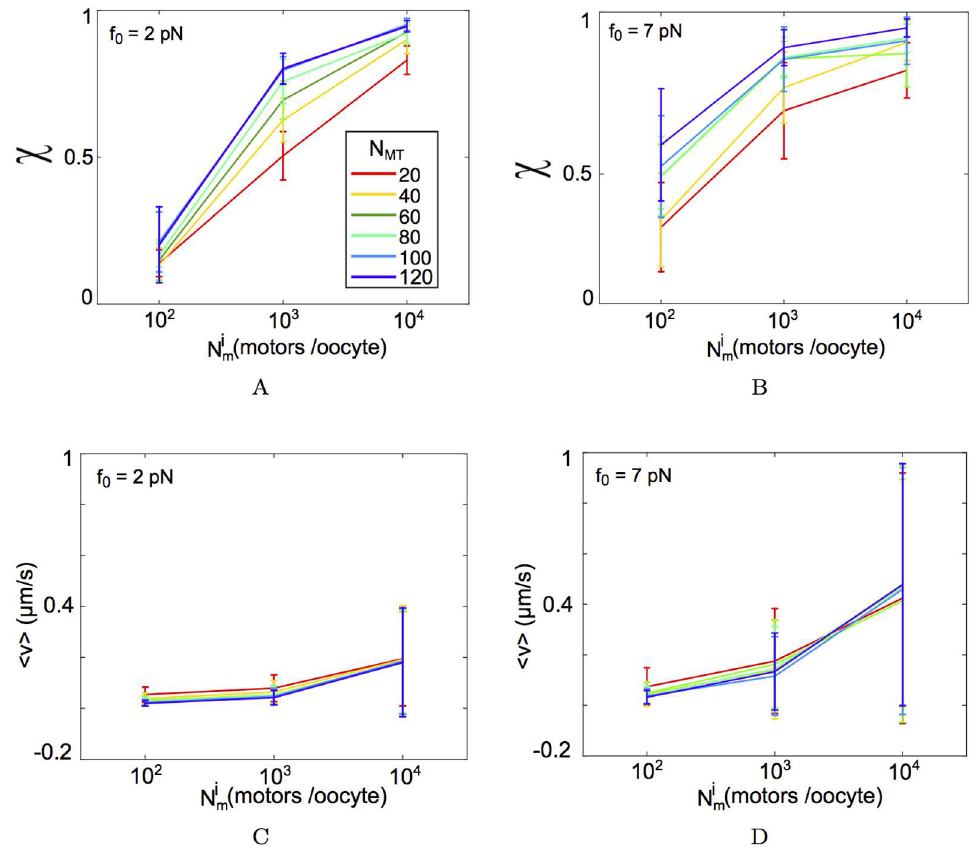
Fig 5. Effect of varying MTs per aster and motor density. MTOCs in the optimized motor gradientnucleated at d n = 15 μ m from the chromatin edge, were simulated for increasing MTs per aster ( N MT ): 20, 40, 60, 80, 100 and 120 (colors). (A, B) The directionality χ and (C, D) mean velocity ( h v i ) are plotted for f 0 = 2 pN and, f 0 = 7 pN ¼ 10 2 to 10 4 motors/oocyte (x-axis). All values are mean ± s.d. from 10 for motor densitiesrangingbetween N i m